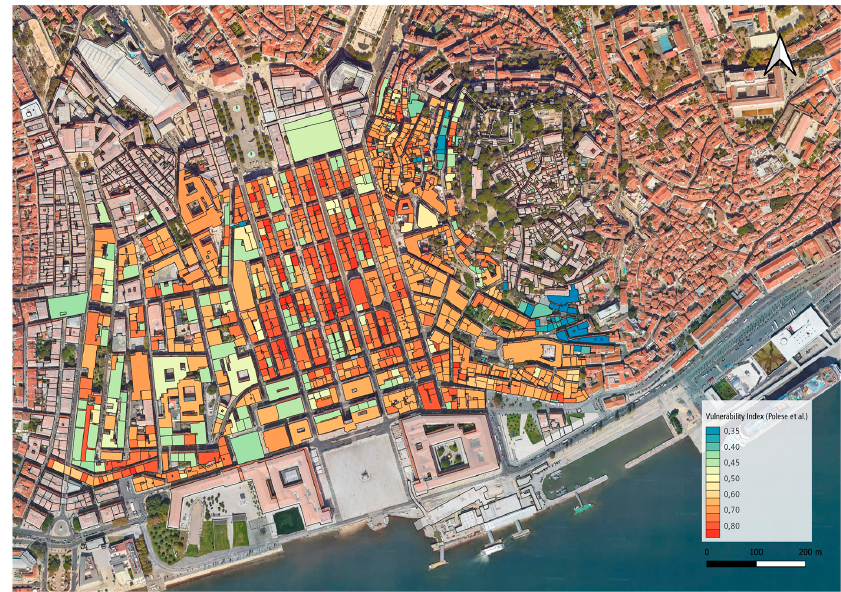
Figure 11. Vulnerability calculated based on the Polese et al. method (2011).